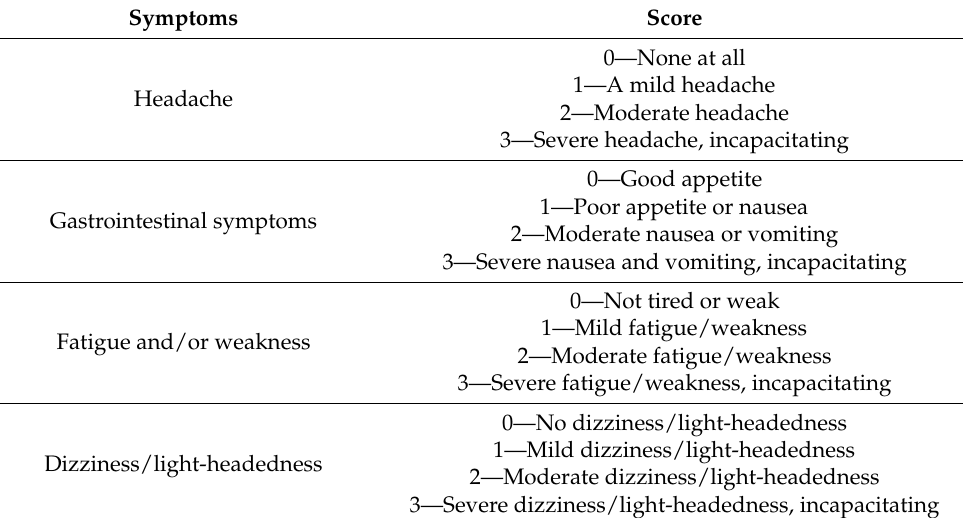
Table 1. Lake Louise Questionnaire Score for diagnosis of